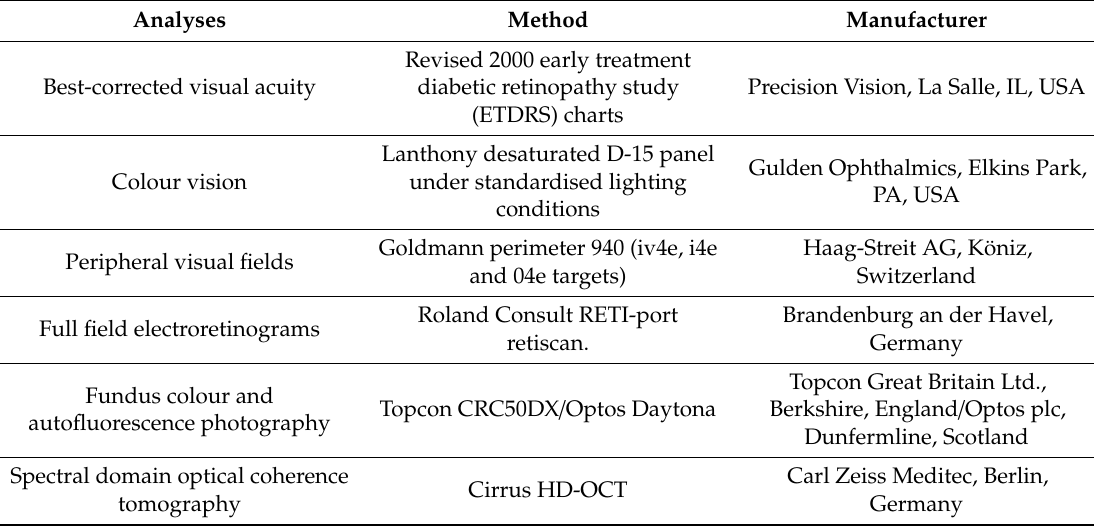
Table 1. Table of typical assessments, instruments, and manufacturers routinely used as part of Target 5000